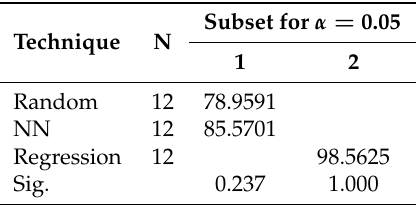
Table 11. Duncan: Homogonous average convergencesubset.